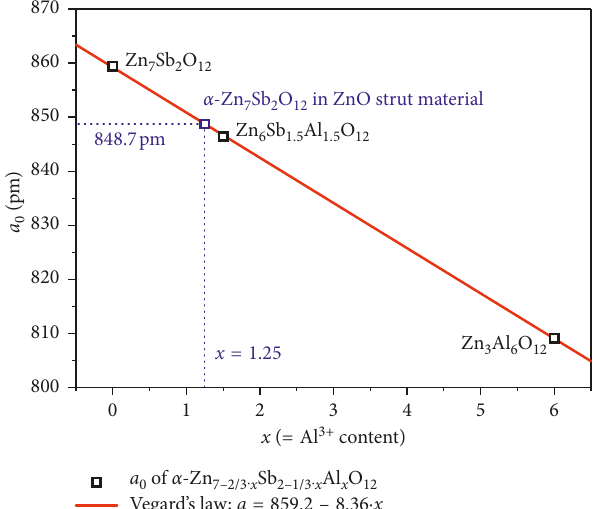
Figure 5: EDS analysis averaged from 9 separate EDS spectra 7 − 2/ recorded on an uniaxially pressed slab of the ZnO strut material. Inset : Signals of the trace elements Al, Bi, and Sb. Table 2: Properties of open-celled zinc oxide ceramic foams. The total porosity and cell porosity values refer to the geometric foam volume and the ratio V pores / V foam . The strut porosity is based on the strut volume and the ratio V strut pores / V struts as determined by the water immersion technique.